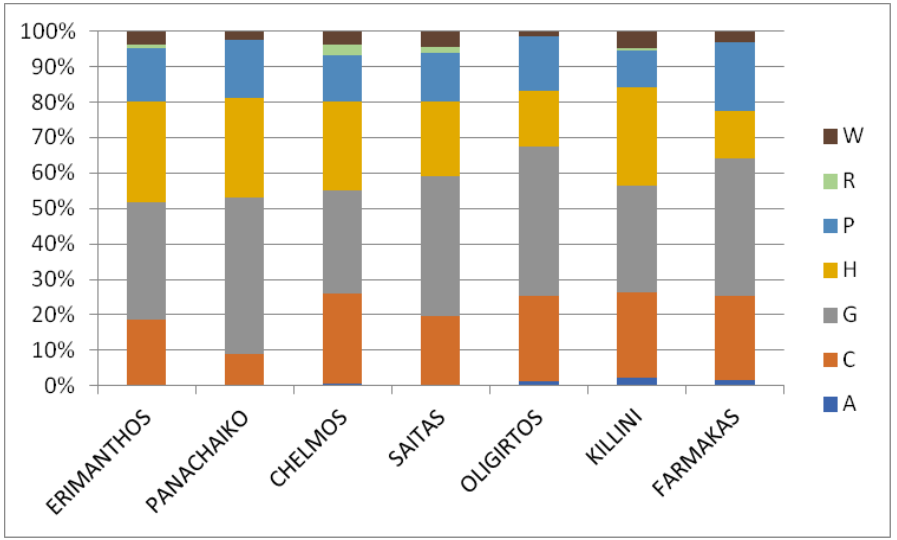
Figure 7. Proportion of the Greek endemic taxa hosted in each habitat category for Mts.